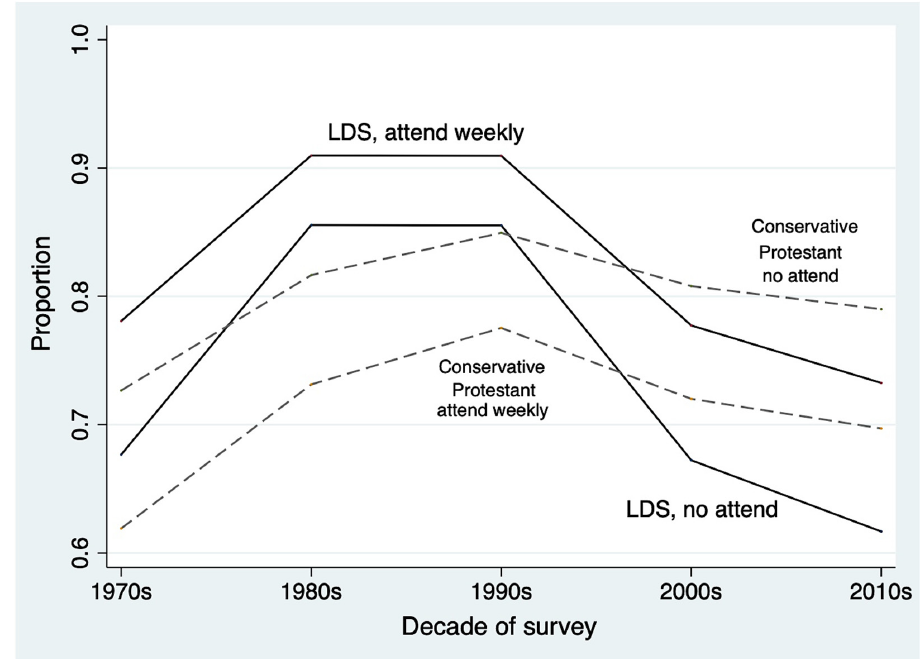
Figure 3. Proportion supporting the death penalty among Latter-day Saints and conservative Protestants, by decade of survey and religious service attendance, General Social Surveys, 1974–2018. Note: the predicted values are based on a model that includes all the variables listed in Table